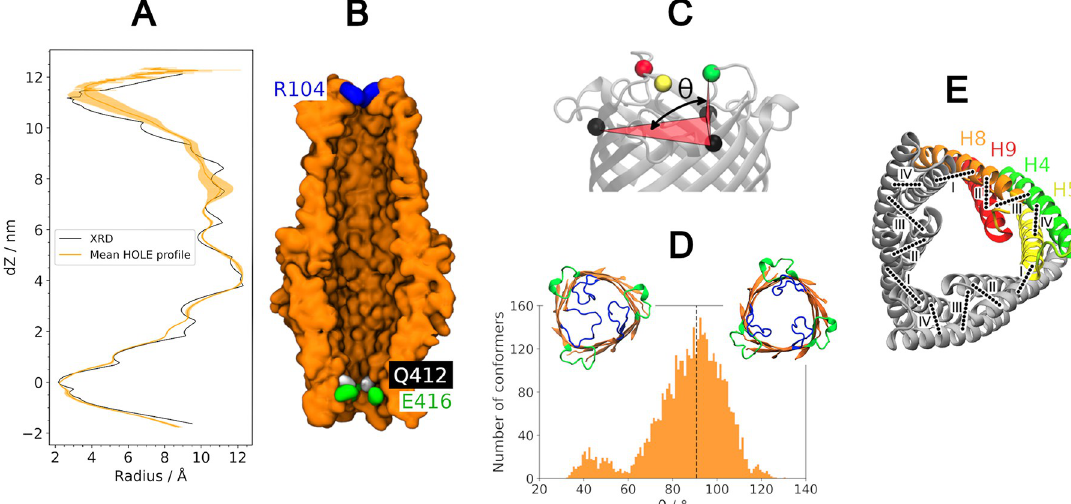
Fig 6. Channel diameter constriction regions. (A) HOLE profile of the CmeC channel. HOLE profile from the x-ray crystal structure shown in black, average profile across the final 100 ns of the three equilibrium simulations, with associated standard deviation, in orange. There is little variation is observed at the periplasmic constriction defined by residues E416 and Q412. The extracytoplsamic constriction, defined by the R104 residues of L1, shows more variation; the extracellular loops visit both the open and closed conformations freely. (B) cutaway of CmeC for scale for the HOLE profile. The two constriction regions align with the residues identified as constricting by Su et al. (30) (C) The dihedral angle determining the degree of opening of the L1 loops is defined by the three N112 alpha carbons (black) and one R104 alpha carbon (red, green, yellow). (D) Histogram of the dihedral angles observed over the three equilibrium simulations, with snapshots of loops more closed (left) and more open (right) than the XRD structure (black dashed line). (E) Circular inter- and intraprotomer hydrogen bonding network between the helices of the coiled coil domain. I: Interprotomer (H5-H8’) salt bridges R370-E226, N385- E212, R395-E201. II: Intraprotomer (H8-H9) hydrogen bond W421- E390. III: Intraprotomer (H9-H4) Hydrogen bonding and salt bridges K432-E171, N429- N172, Q161-D441, N172/N168-N430. IV: Intraprotomer (H4-H5) salt bridge K222-E173.